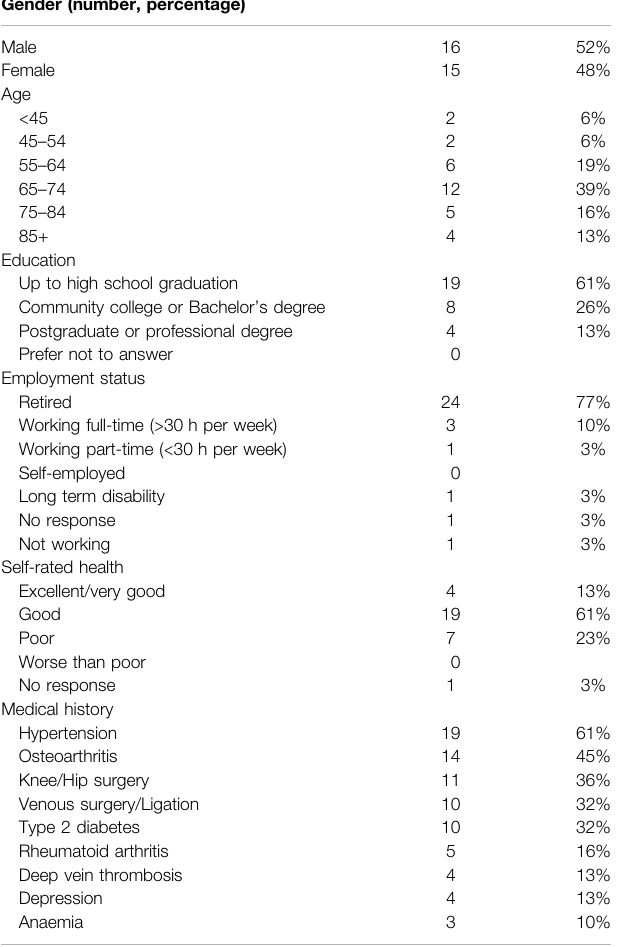
TABLE 2 | Participant characteristics ( n (cid:1)